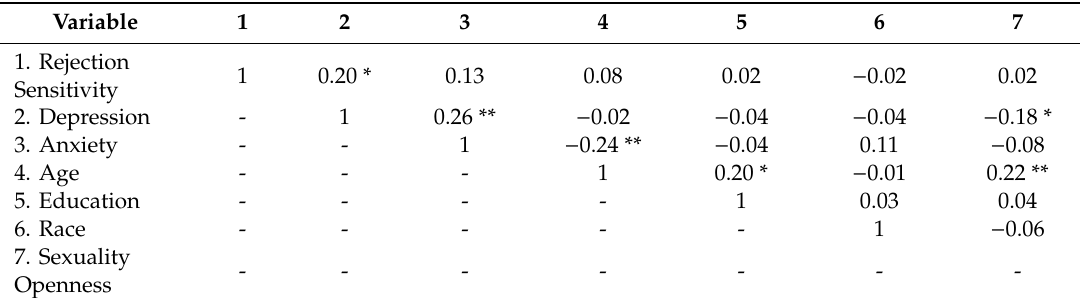
Table 3. Correlations Between